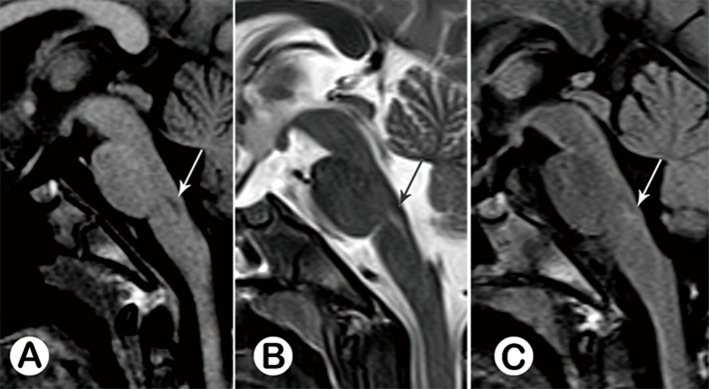
Follow-up study of previous case (Female, 6 years 8 months old,from Fig 2) in 3 years 8 months.Sagittal MR images revealed the lesion was smaller while compared with Fig 2, demonstrating prolonged T1 (A, white arrow) and prolonged T2 (B, black arrow) signal, and hyper-intensive signal on FLAIR(C, white arrow). This subject had special neurological sequelae, which were irregular breath and involuntary extremity tremor during sleeping at night.